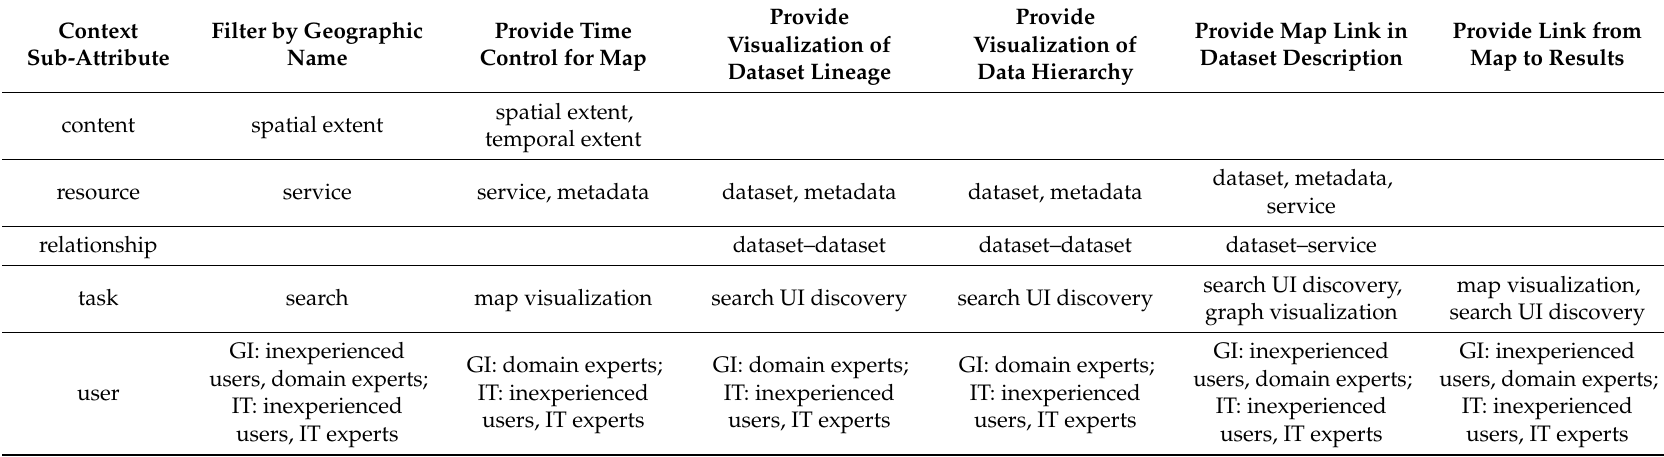
Table 3. Context and sub-attribute content, resource, relationship, task, and user for six usability patterns for GI web applications. IT—information